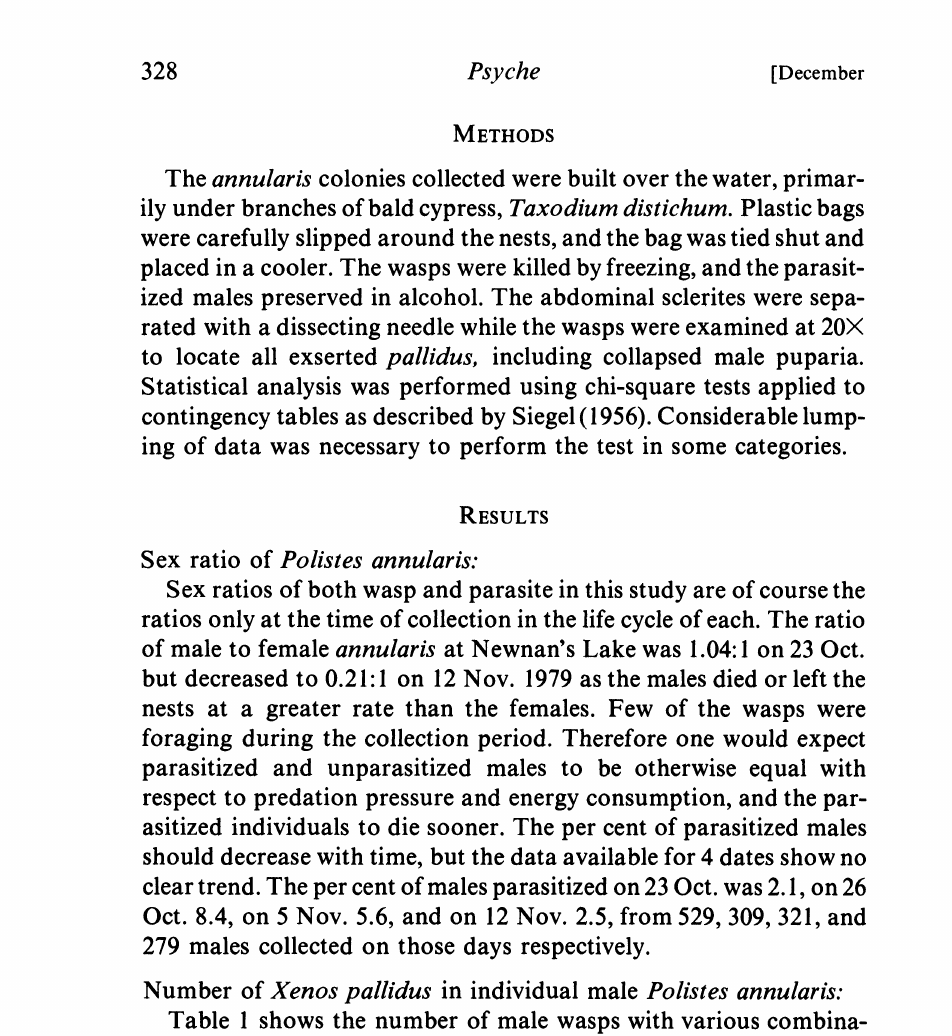
shows the number of male wasps with various combina- tions of male and female parasites. Only host had as many as